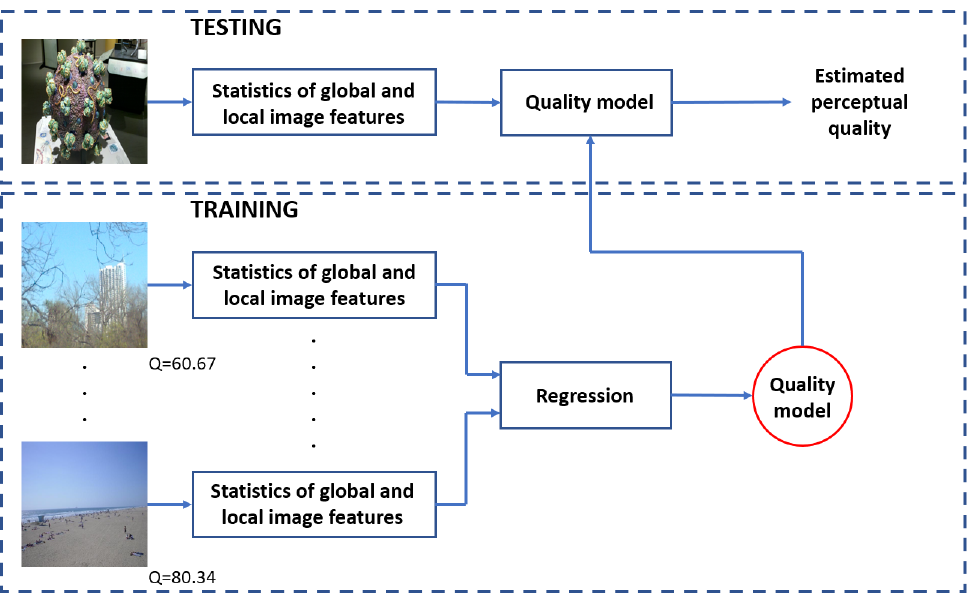
Figure 1. High-level flowchart of our proposed method which can be divided into training and test steps. In the training phase, the statistics of global and local image features extracted from the labeled training images are used to train the quality model, which is later used in the testing phase to assess previously unseen